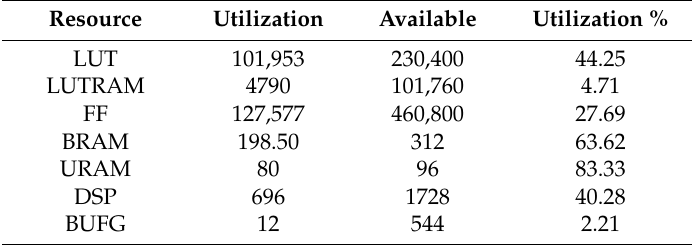
Table 6. Resource utilization for the compressed AlexNet.